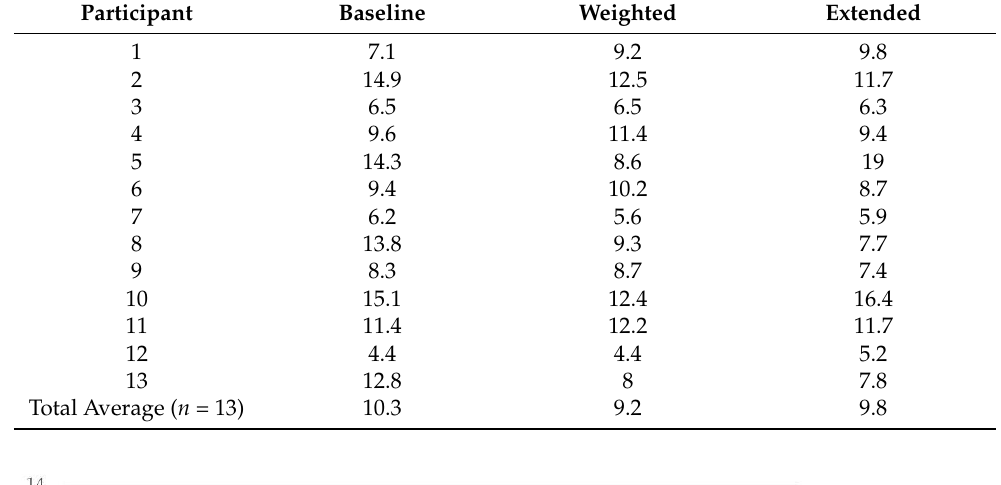
Table 1. Participants’ average throwing accuracy expressed as distance from the target (in cm).